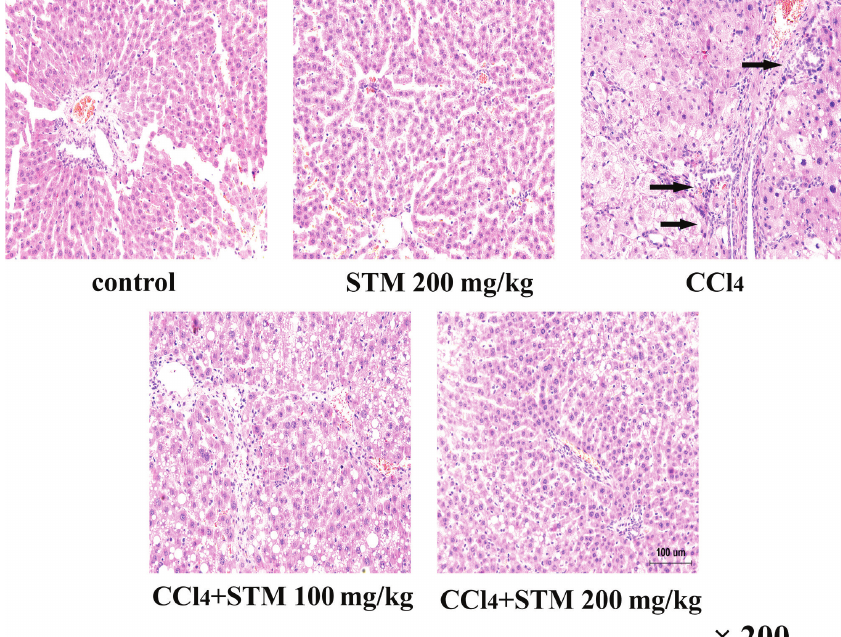
-induced histology changes in the liver. (A) Control group, (B) STM 200 mg/kg group, (C) CCl FIGURE 1 - STM alleviated CCl 4 group, (D) CCl +STM 100 mg/kg group, (E) CCl +STM 200 mg/kg group. Arrows represent the large amount of inflammatory 4 4 cell infiltration. H&E staining, Magnification: